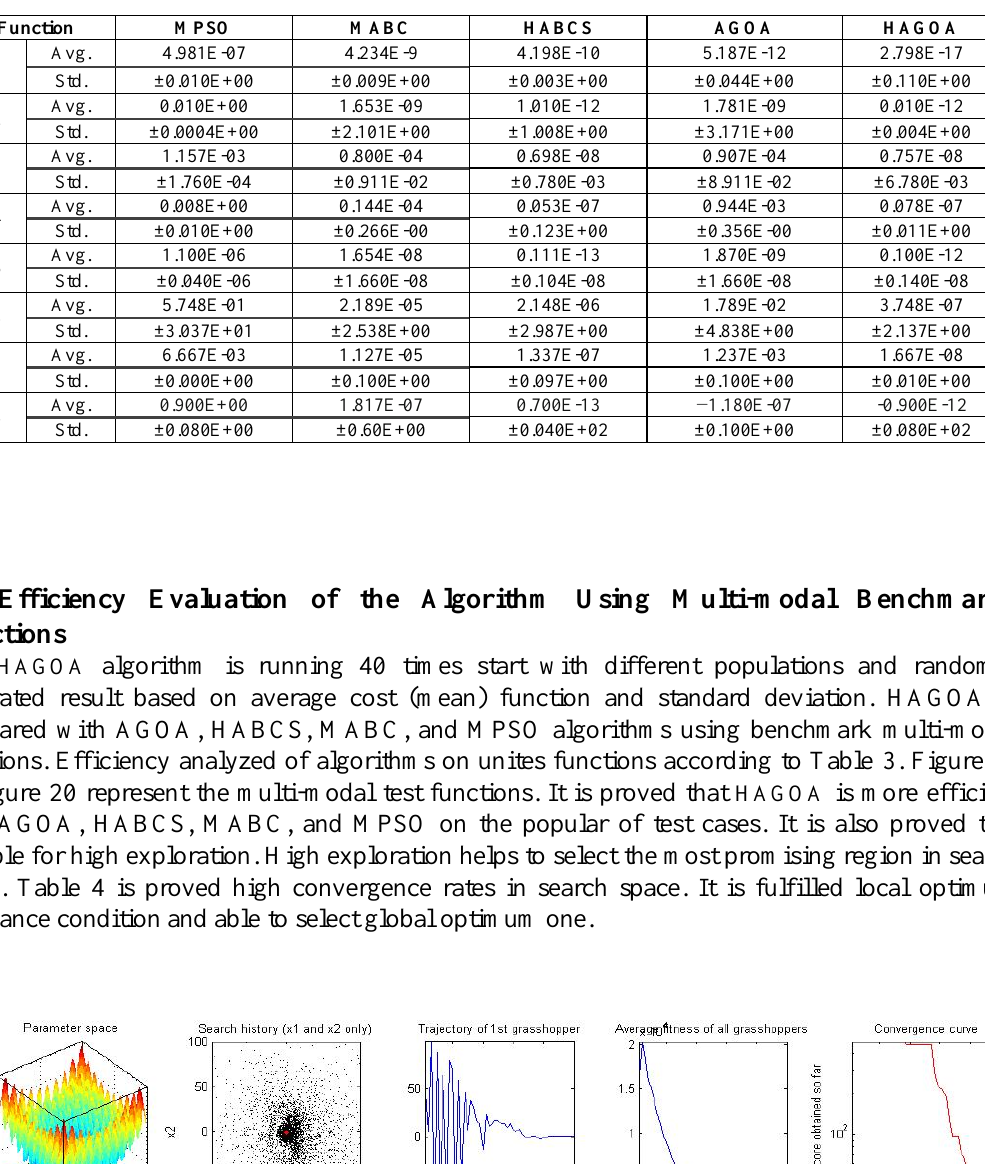
Table 3. Performance evaluation on unimodal functions